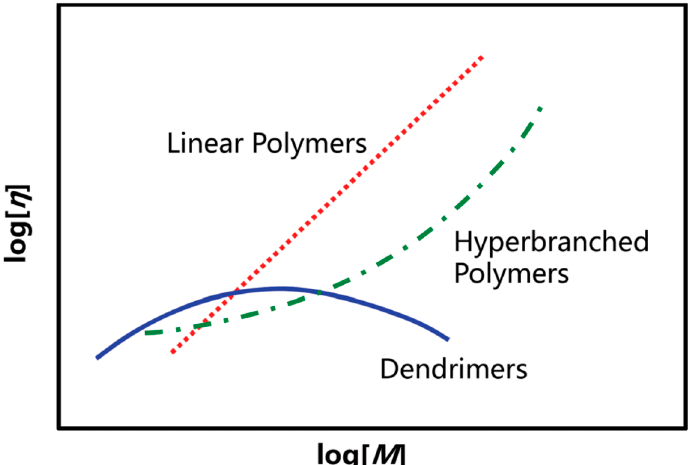
Figure 1. Relationship between log MW and log [ η ] for linear, dendrimer, and hyperbranched molecules. Reproduced from [31] with permission from the Royal Society of Chemistry.